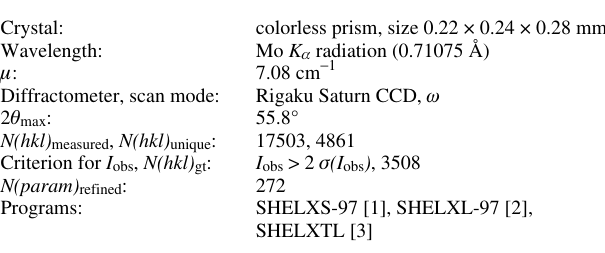
Table 1. Data collection and handling.